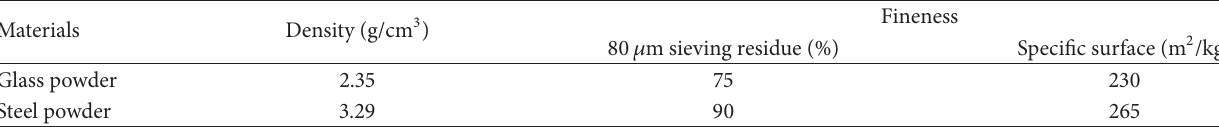
Table 3: Physical properties of glass powder and steel